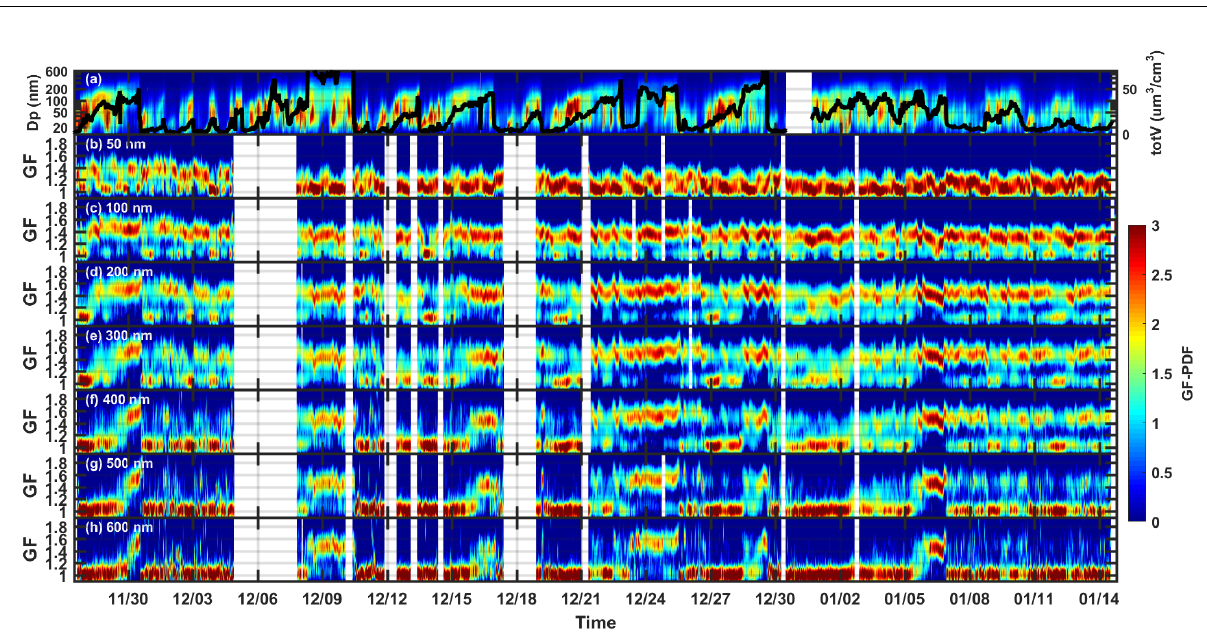
Figure 3. Temporal evolutions of (a) particle number size distribution and integrated volume concentration (black line), (b) – (h) growth factor probability distributions over different sizes from 50–600nm. The color contour in (a) denotes the particle number concentration (d n/ dlog D p (cm − 3 )) and in (b) – (h) denotes the growth factor probability distribution function. The y axis of (a) is particle diameter in